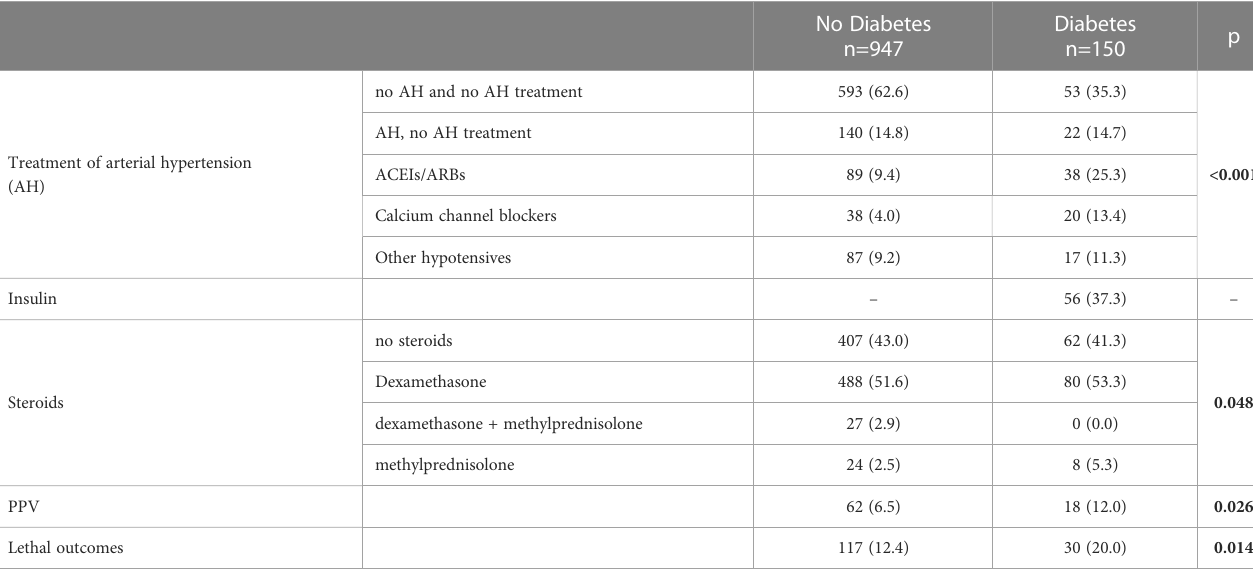
ACEIs, Angiotensin-converting-enzyme inhibitors; ARBs, angiotensin II receptor blockers; PPV, positive pressure ventilation. Data are n and %. The comparison of the two groups was performed according to Fisher ’ s exact test or the chi-square test. Bold values denote statistical signi fi cance at the P < .05